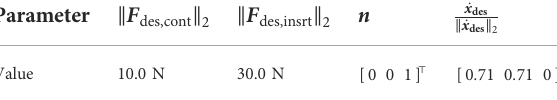
TABLE 2 Prede fi ned parameters for the unscrewing skill. The value for _ x des (cid:3) _ x des (cid:3) 2 denotes the motion direction that is to be followed during the search on the surface of this object.